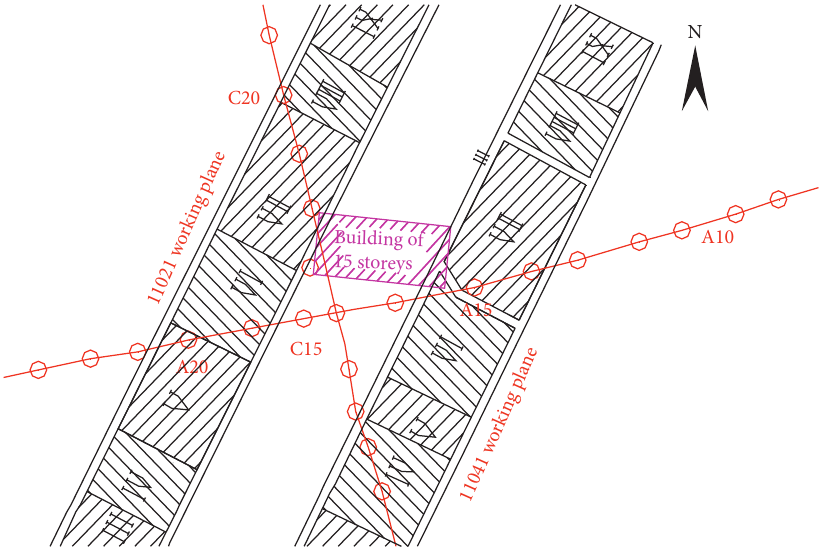
Figure 12: Overview of observation points around the building.